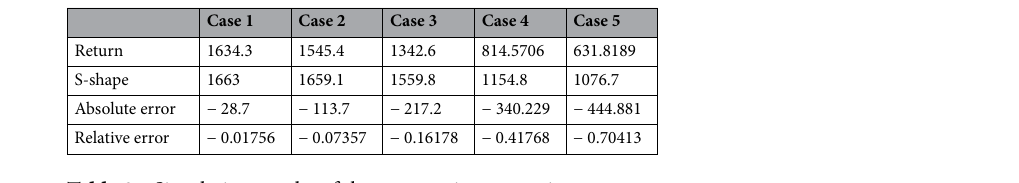
Table 8. Simulation results of the two routing strategies.